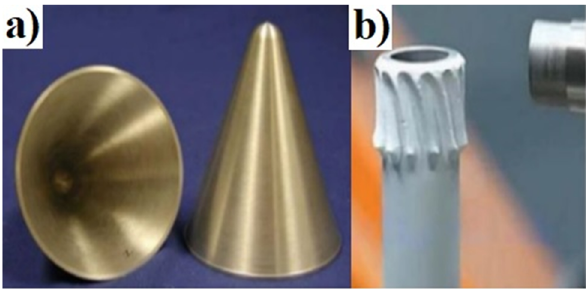
Figure 9: CSAM parts of intricate structures: ( a ) cone and ( b ) gear [ 51 ]